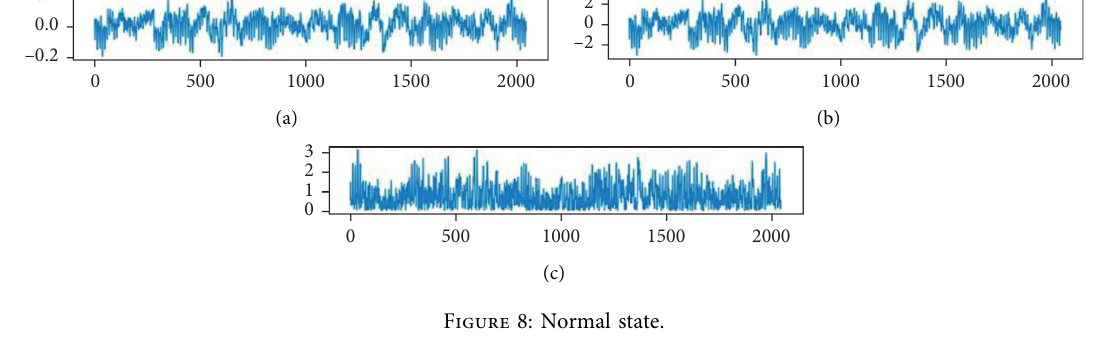
Figure 7: The transformation results of RE fault (a), IR fault (b), and OR fault (c) with 0.007-inch damage diameter. 0.2